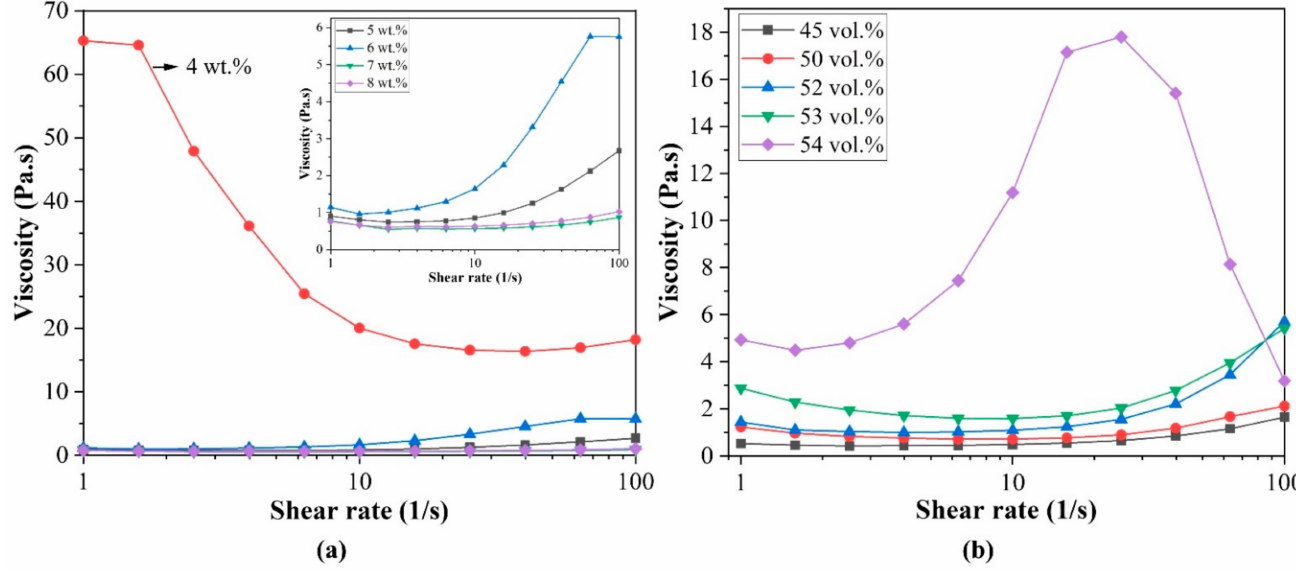
Figure 4. Viscosity curves of the planetary milled mica slurry with different ( a ) concentrations of the dispersant and ( b ) solid loading (dispersant concentration = 7